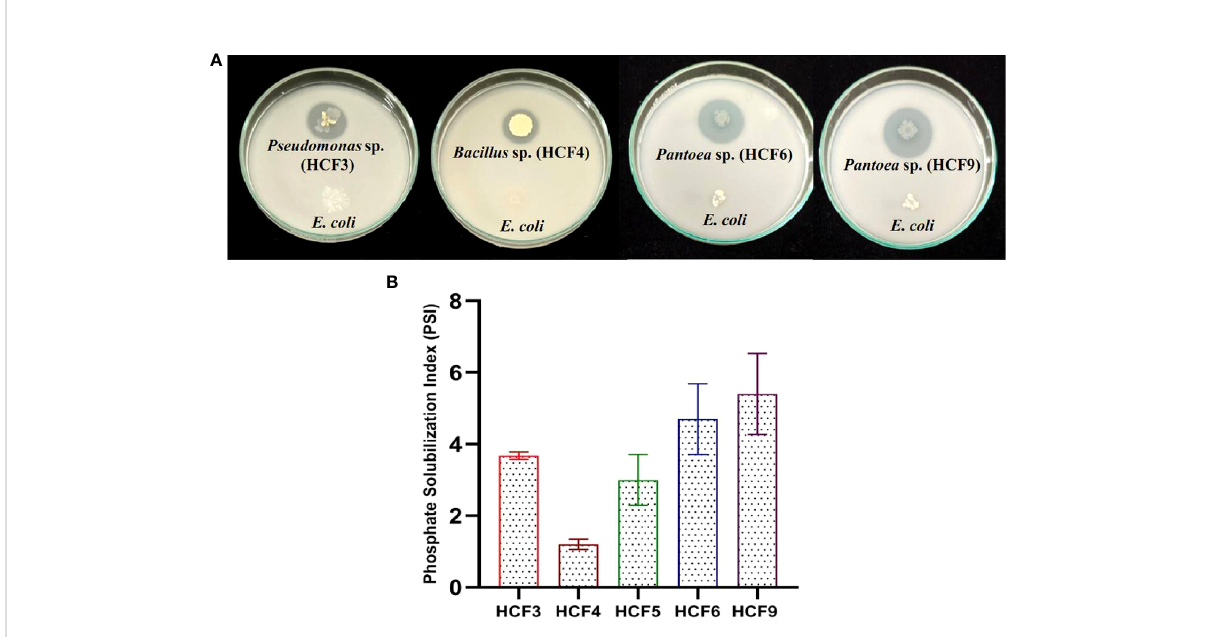
FIGURE 1 Phosphate solubilization by endophytic bacterial isolates on National Botanical Research Institute ’ s Phosphate (NBRIP) solid media. (A) Representative Petriplates showing halo zones by the test isolates along with E . coli control. (B) Phosphate solubilization index (PSI) of the bacterial isolates. Error bars represent the standard error of the means of two independent experiments.